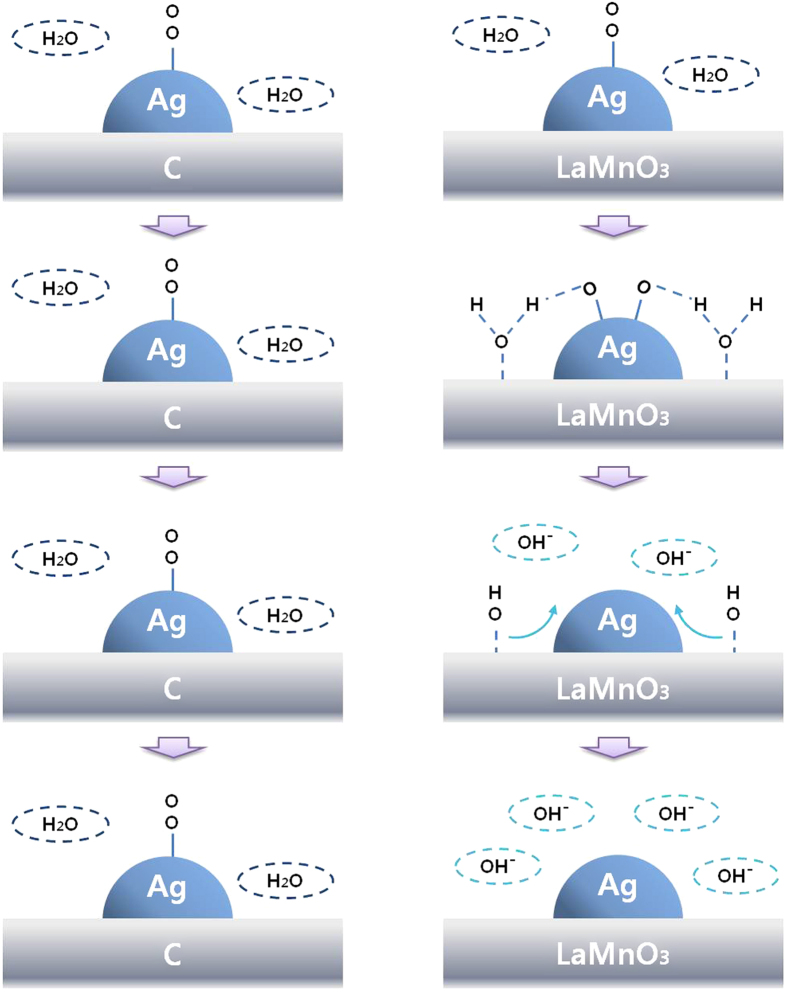
ORR scheme at around −0.1 V vs. Hg/HgO for Ag/C and Ag/LaMnO3.